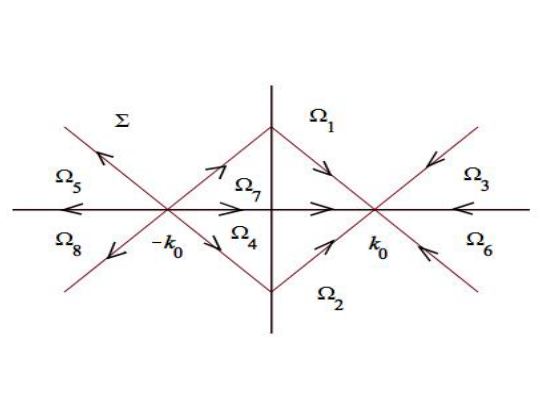
Figure 4. The oriented jump contour Σ